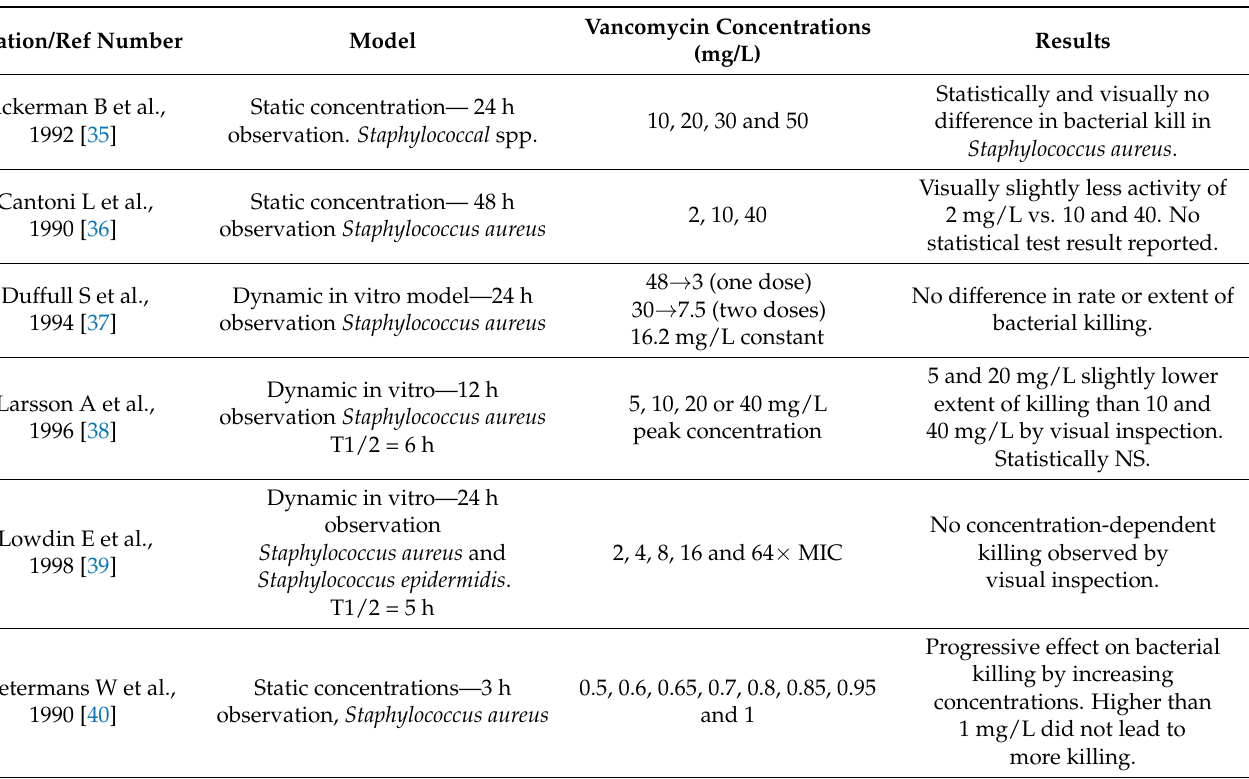
Table 2. In vitro pharmacodynamic studies of